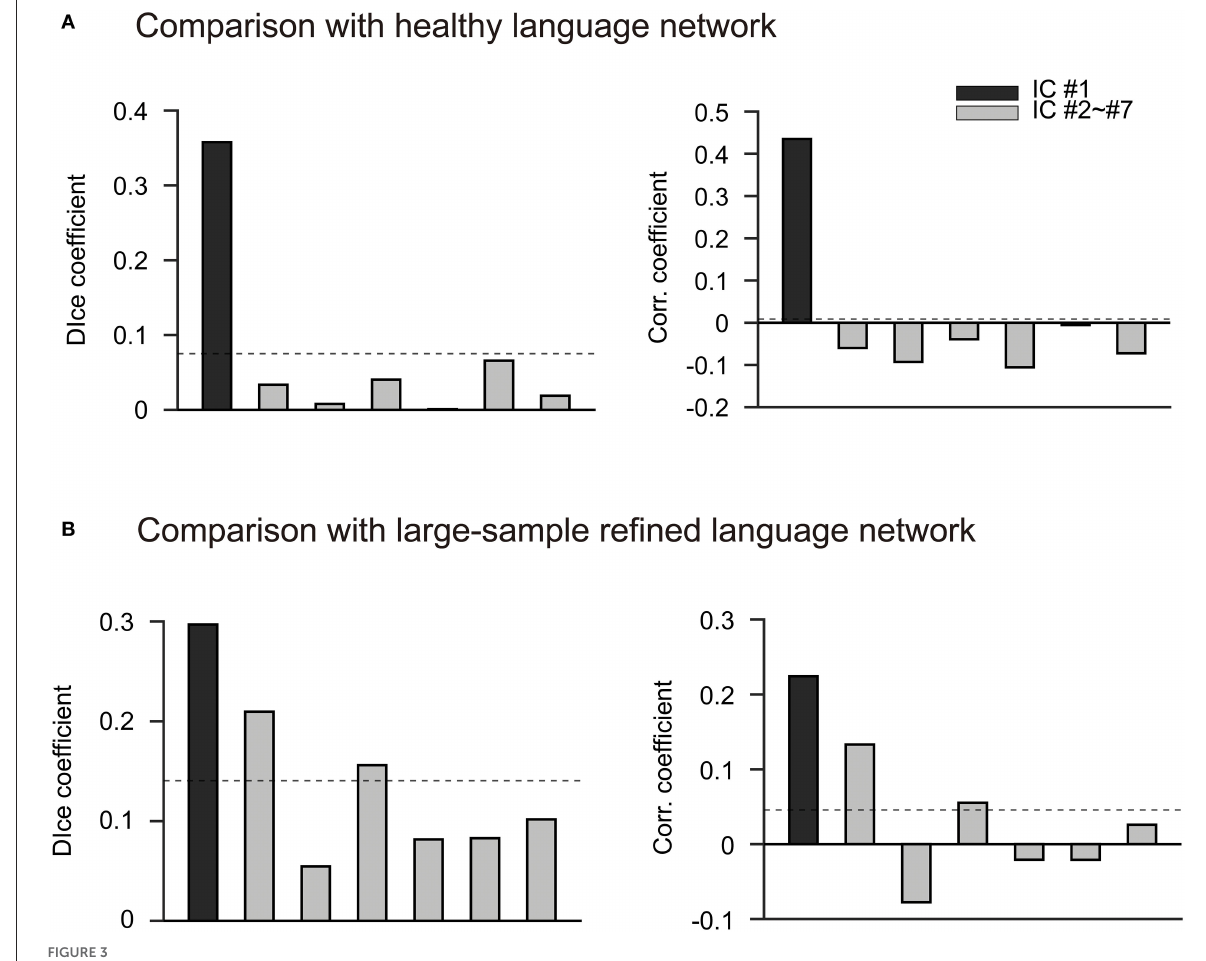
FIGURE3 IC#1 has the most advantage in the spatial overlap and correlation with two well-established language networks. (A) Comparison with the parcellated language network in healthy people. Bar chart shows the comparison of seven ICs obtained by ICLM with the healthy language network defined in Yeo 17 networks. The Yeo 17 networks are parcellated from the resting-state imaging of healthy participants. The black bar indicates IC #1, and the gray bars indicate IC#2 to IC#7. The dashed lines in this figure represent the average correlation coefficient or dice coefficient across the seven ICs. Overall, IC#1 is significantly higher than the other ICs in terms of spatial overlap (left, DICE = 0.36) and correlation (right, r = 0.22) with the healthy language network. (B) Comparison with the large-sample refined language network. The comparison of the seven ICs obtained by ICLM with the language network from Neurosynth is shown. This target network is regarded as the “gold standard” since it is derived from the results of a meta-analysis of 1,101 language-related studies (www.neurosynth.org). The black bar indicates IC#1, and the gray bars indicate IC#2 to IC#7. The dashed lines in this figure represent the average correlation coefficient or dice coefficient across the seven ICs. Again, IC#1 exhibits the highest overlap (left, DICE = 0.3) and correlation (right, r = 0.44) with the “gold standard” language network, and therefore is defined as the specific lesioned language network in patients with aphasia. corr., correlation; IC, independent component; r , correlation